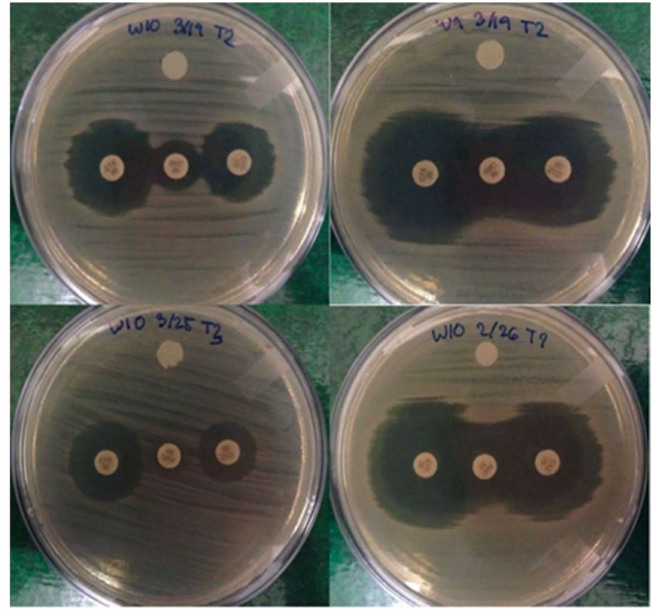
Figure 1. Negative ( left ) and positive ( right ) results for confirmatory screening of E. coli isolates from agricultural irrigation waters in Quezon City and Marikina City, Philippines showing zone extension for ESBL-producing